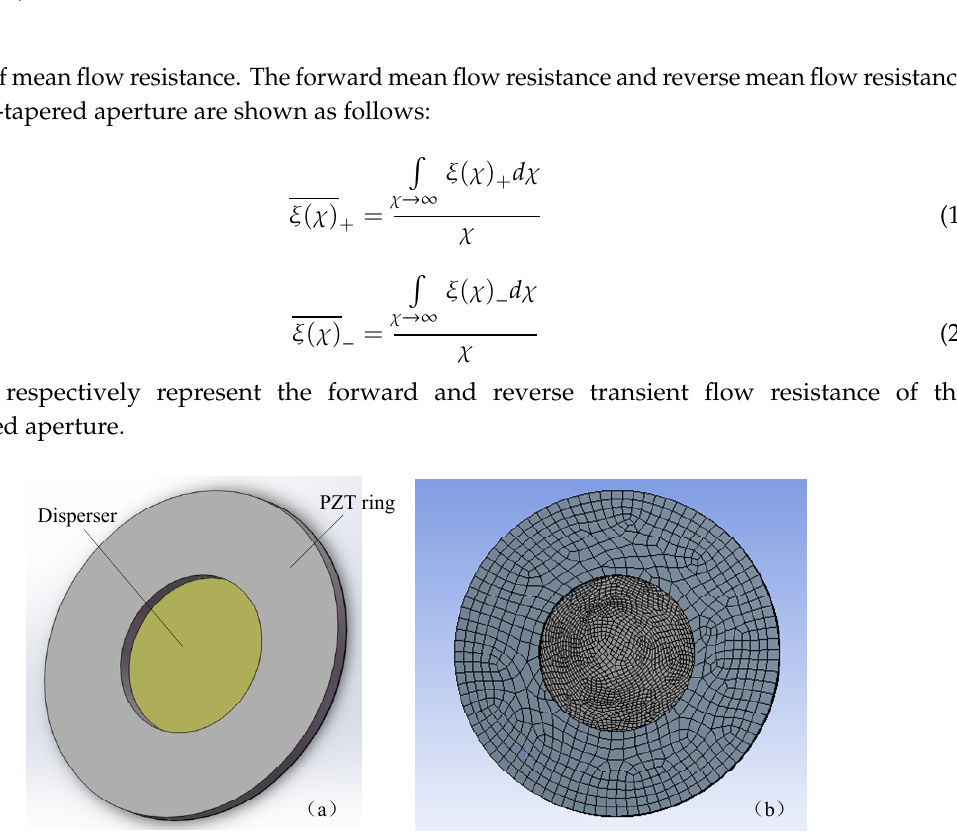
Figure 2. Model and mesh generation of piezoelectric vibrator ( a ) Piezoelectric vibrator model. ( b ) Grid division of piezoelectric vibrator model.